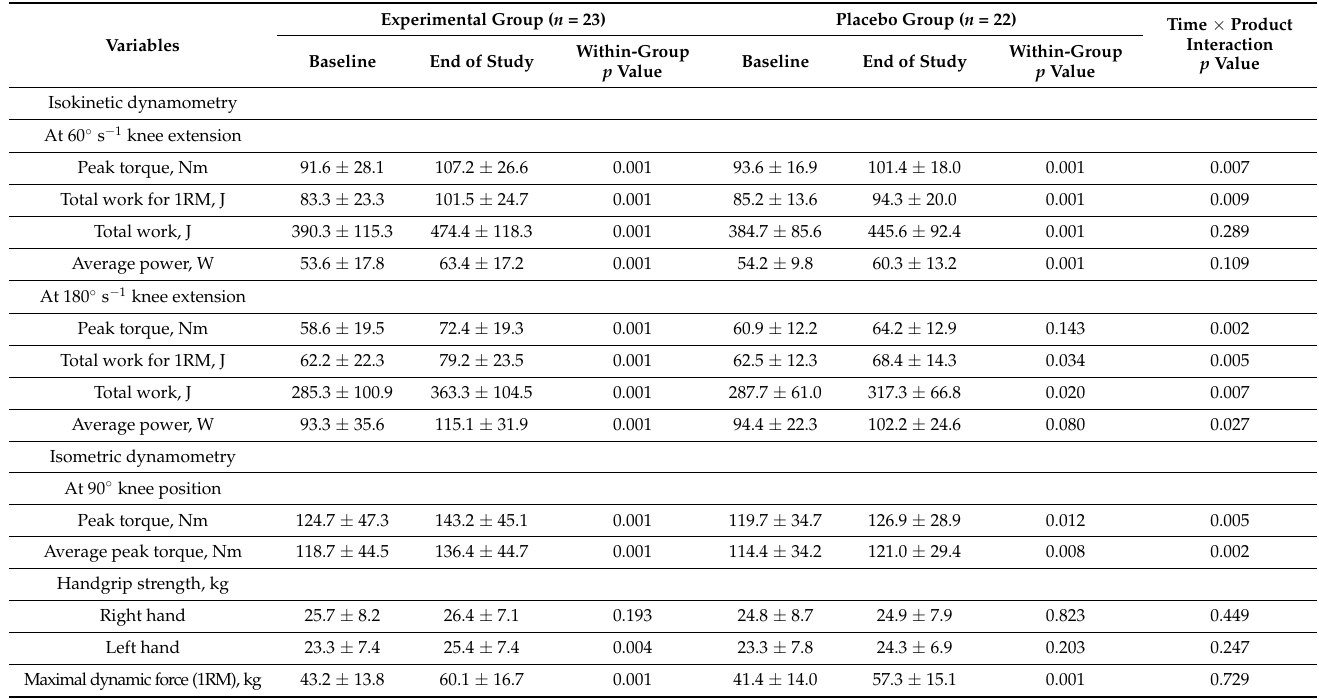
Table 3. Changes of muscle function of knee isokinetic and isometric dynamometry and handgrip strength at the end of the study after 12 weeks of food supplementation with a spinach extract or